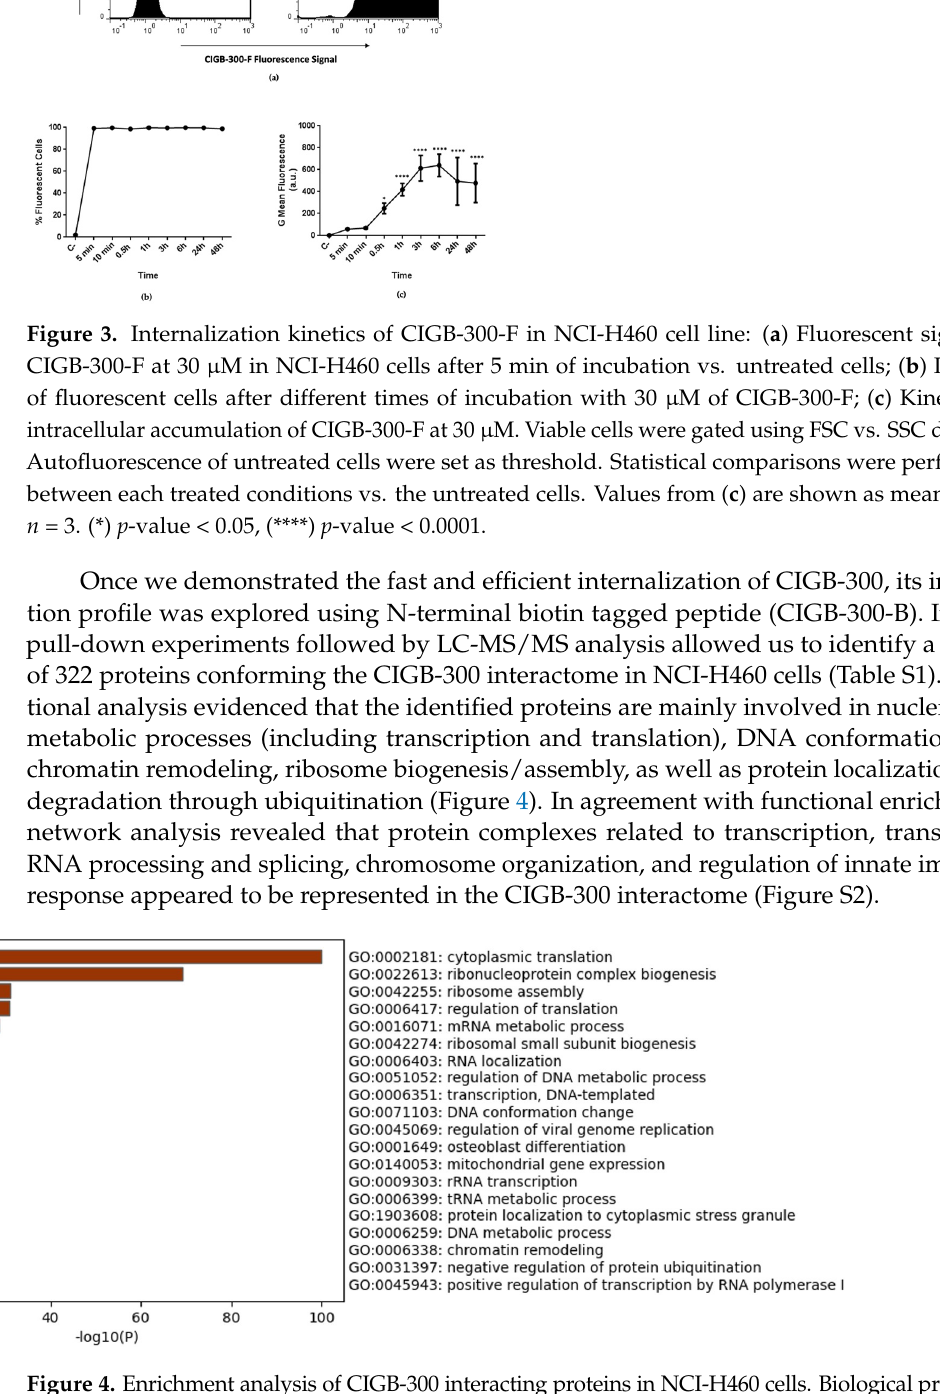
Figure 4. Enrichment analysis of CIGB-300 interacting proteins in NCI-H460 cells. Biological processes significantly represented in the peptide interaction profile ( p -value < 0.01, enrichment factor > 1.5), were identified using Metascape gene annotation and analysis resource (https://metascape.org/, accessed on 1 September, 2022).